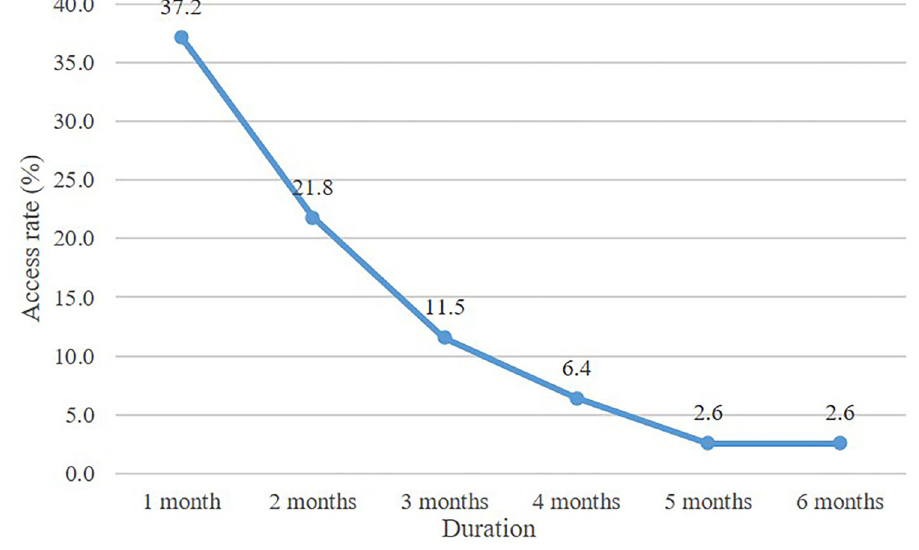
Fig 2. Access rate to PharmQuit in the intervention group within the 6-month follow-up (n = 78).